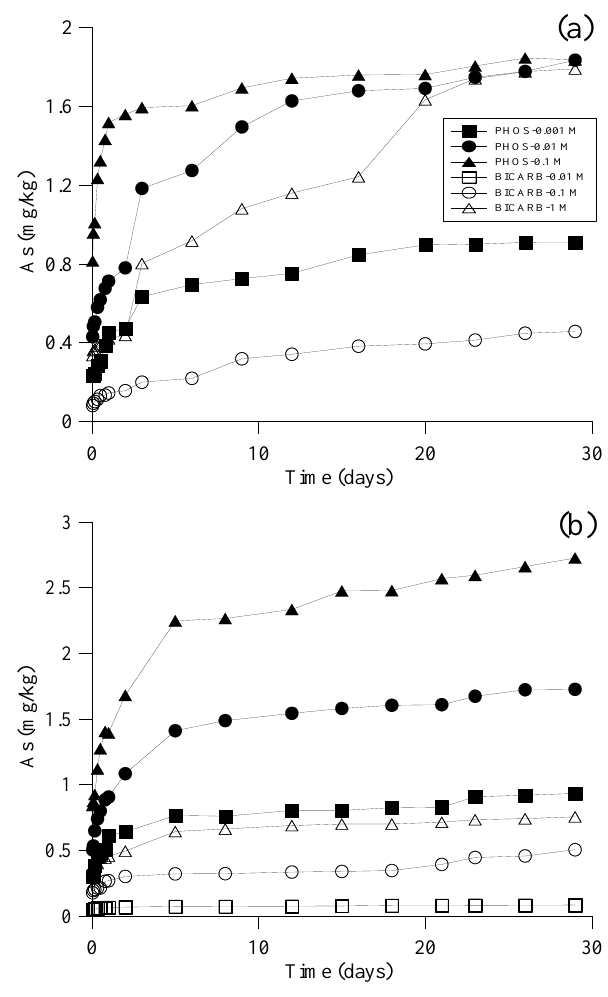
Fig. 8. Time-dependent desorption of arsenic with bicarbonate at 0.01, 0.1, and 1M and phosphate at 0.001, 0.01, and 0.1M from (a) YL6-1 and (b)